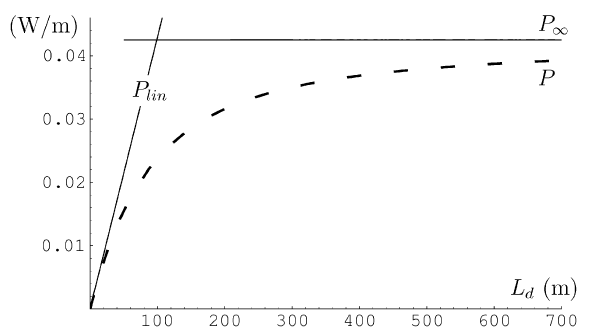
FIG. 4. Power per unit length as a function of the length of the beam screen L d . We use the following parameters: b (cid:1) 19 mm, d (cid:1) 24.5 mm, r b (cid:1) r d (cid:1) 7.1 3 10 2 7 V (cid:1) m, Q (cid:1) 16 nC, s (cid:1) 75 mm, rounded end slots 8 mm 3 1.5 mm. The holes cover a surface of 4.4% of the total surface of the